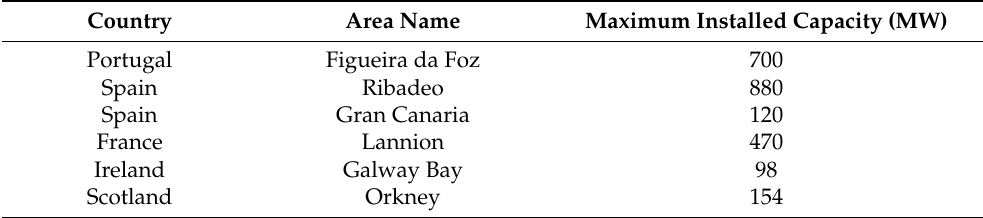
Table 1. Identified areas of high potential and their maximum installed capacity. Country Area Name Maximum Installed Capacity (MW) Figueira da